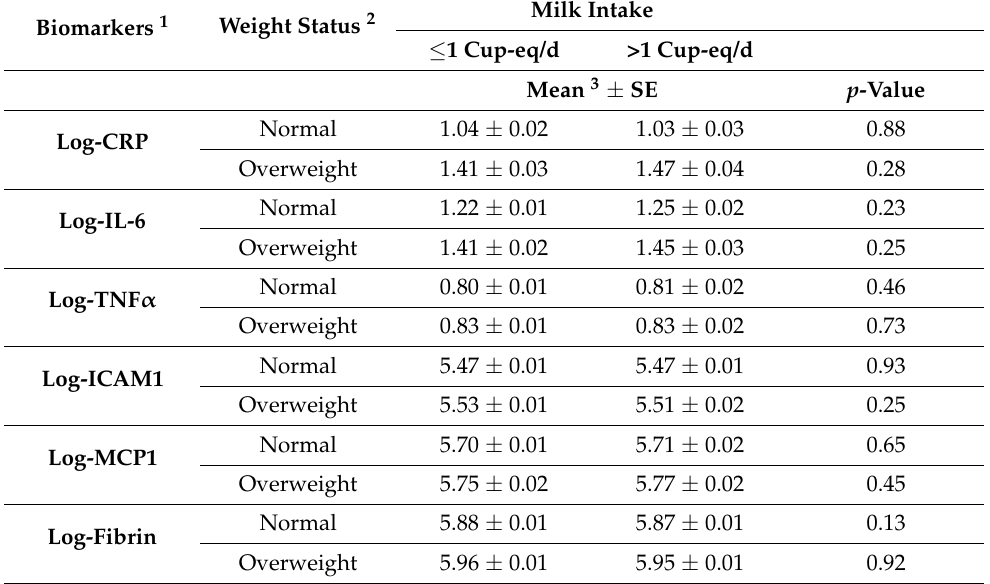
Table 4. Adjusted mean levels of inflammation biomarkers according to combined categories of milk intake and weight